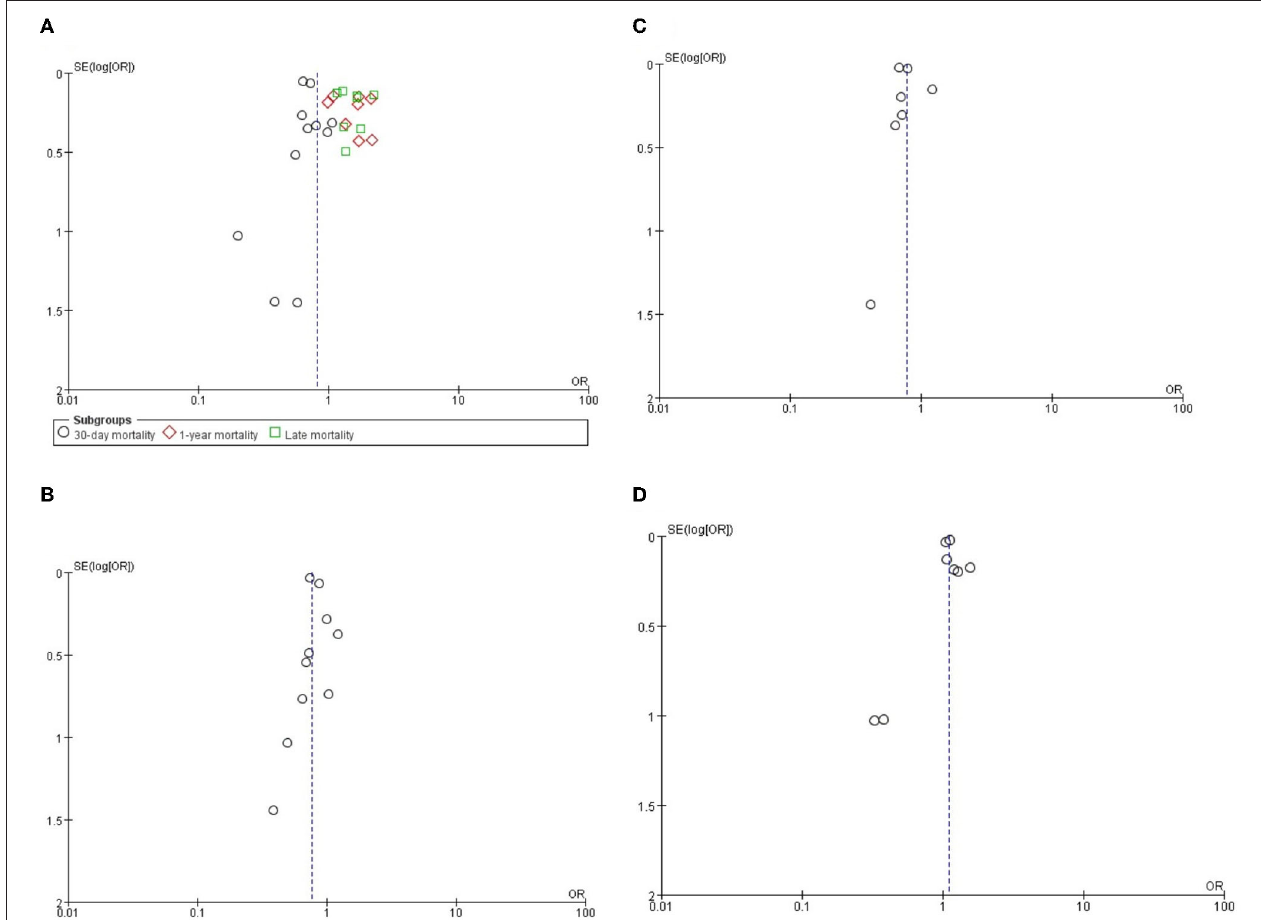
FIGURE 4 | The funnel plots of (A) all-cause mortality, (B) stroke, (C) AKI and (D) new permanent